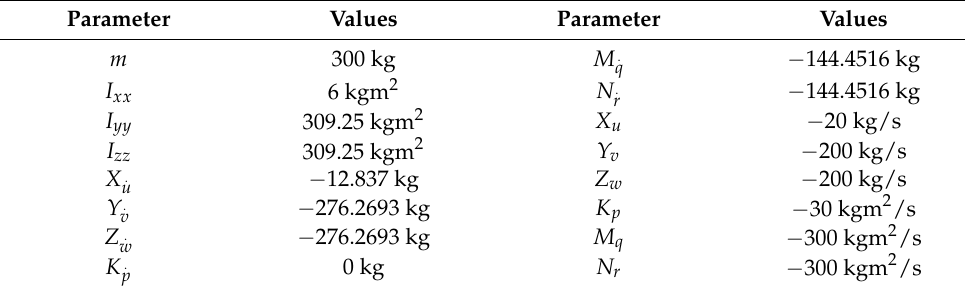
Table 2. Parameter values of towfish used for the simulation.